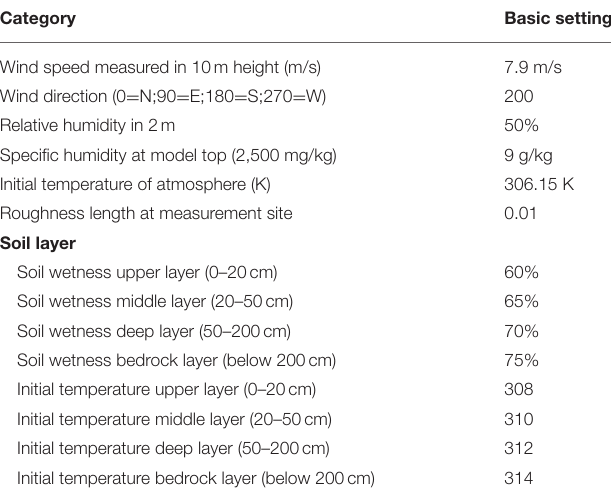
TABLE 1 | Selected input parameters for ENVI-met base